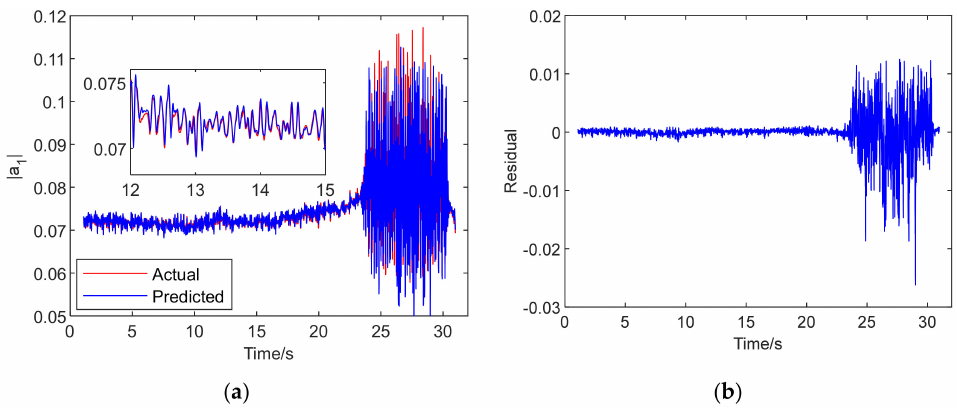
Figure 10. Result of Chaos–K-means–GD–RBF neural network model: ( a ) prediction; ( b )